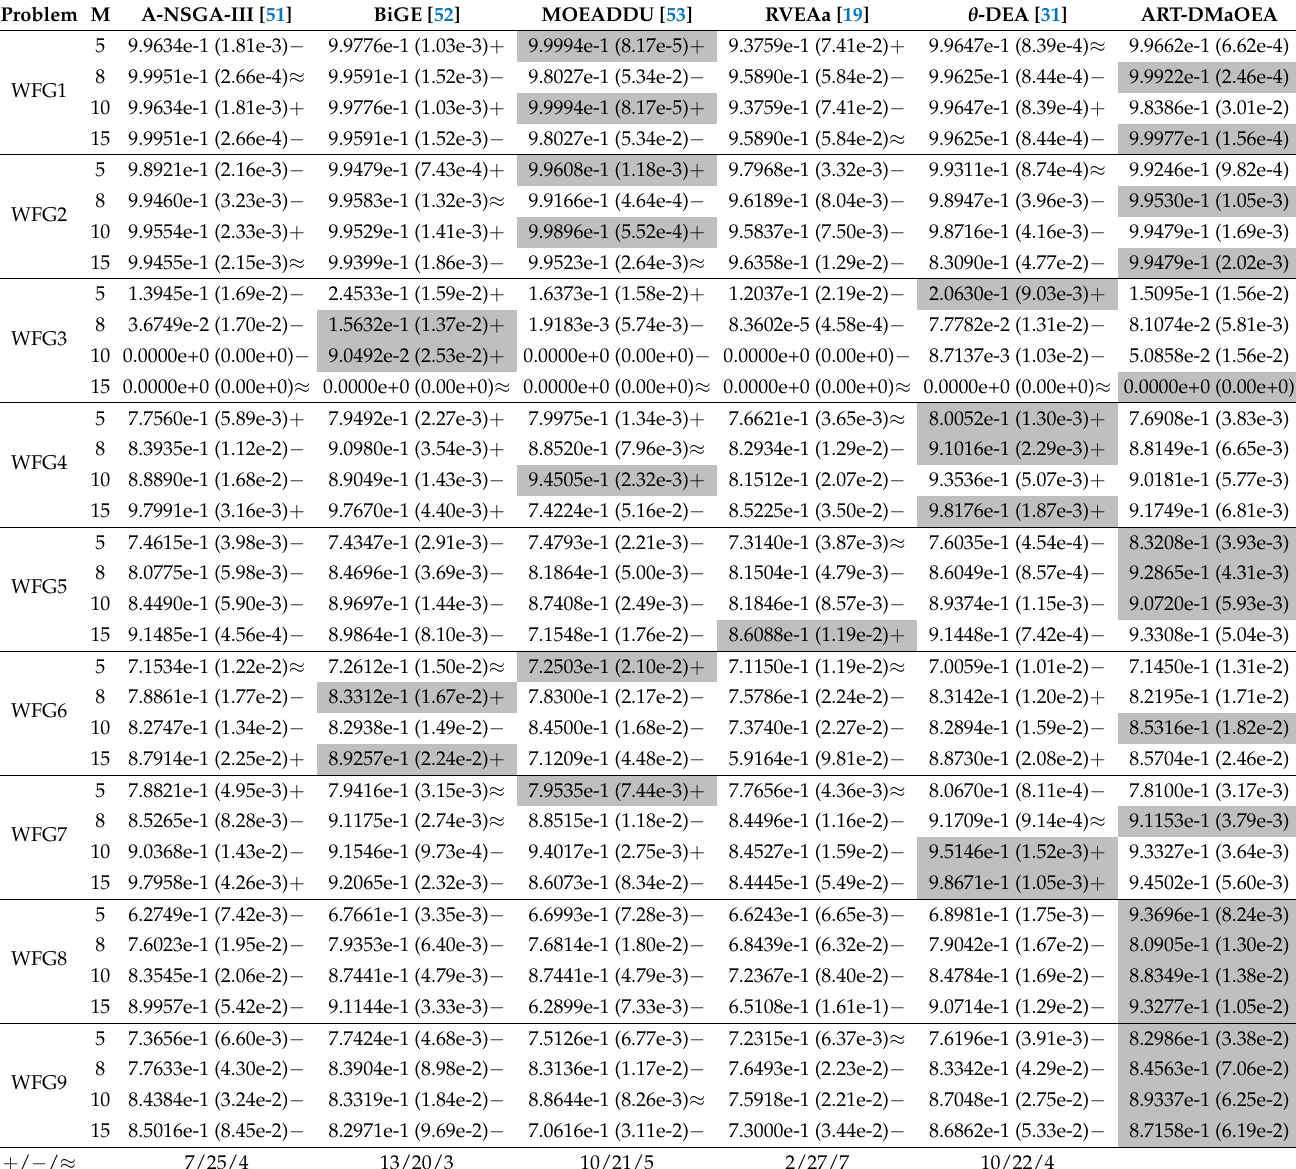
Table 2. HV Results of the six algorithms on benchmarks WFG1-WFG9.